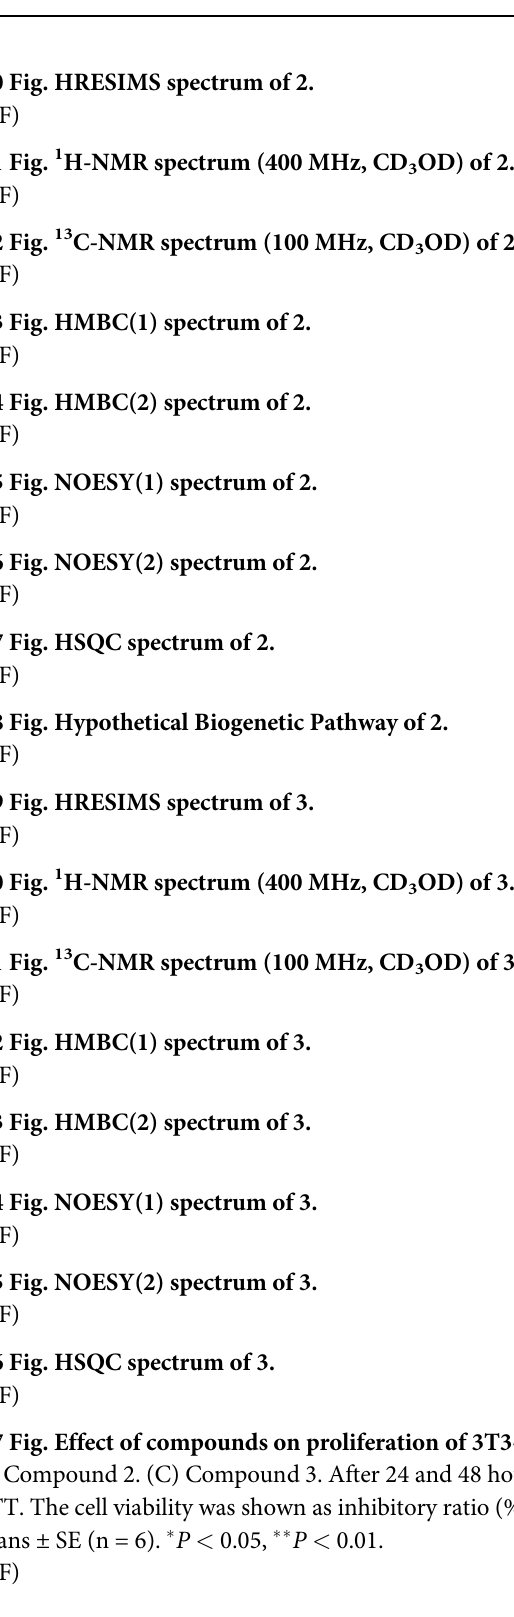
S27 Fig. Effect of compounds on proliferation of 3T3-L1 cells in vitro. (A) Compound 1. (B) Compound 2. (C) Compound 3. After 24 and 48 hours, proliferation was assessed by MTT. The cell viability was shown as inhibitory ratio (% of control). Data are presented as means ± SE (n = 6). (cid:2) P < 0.05, (cid:2)(cid:2) P < 0.01.